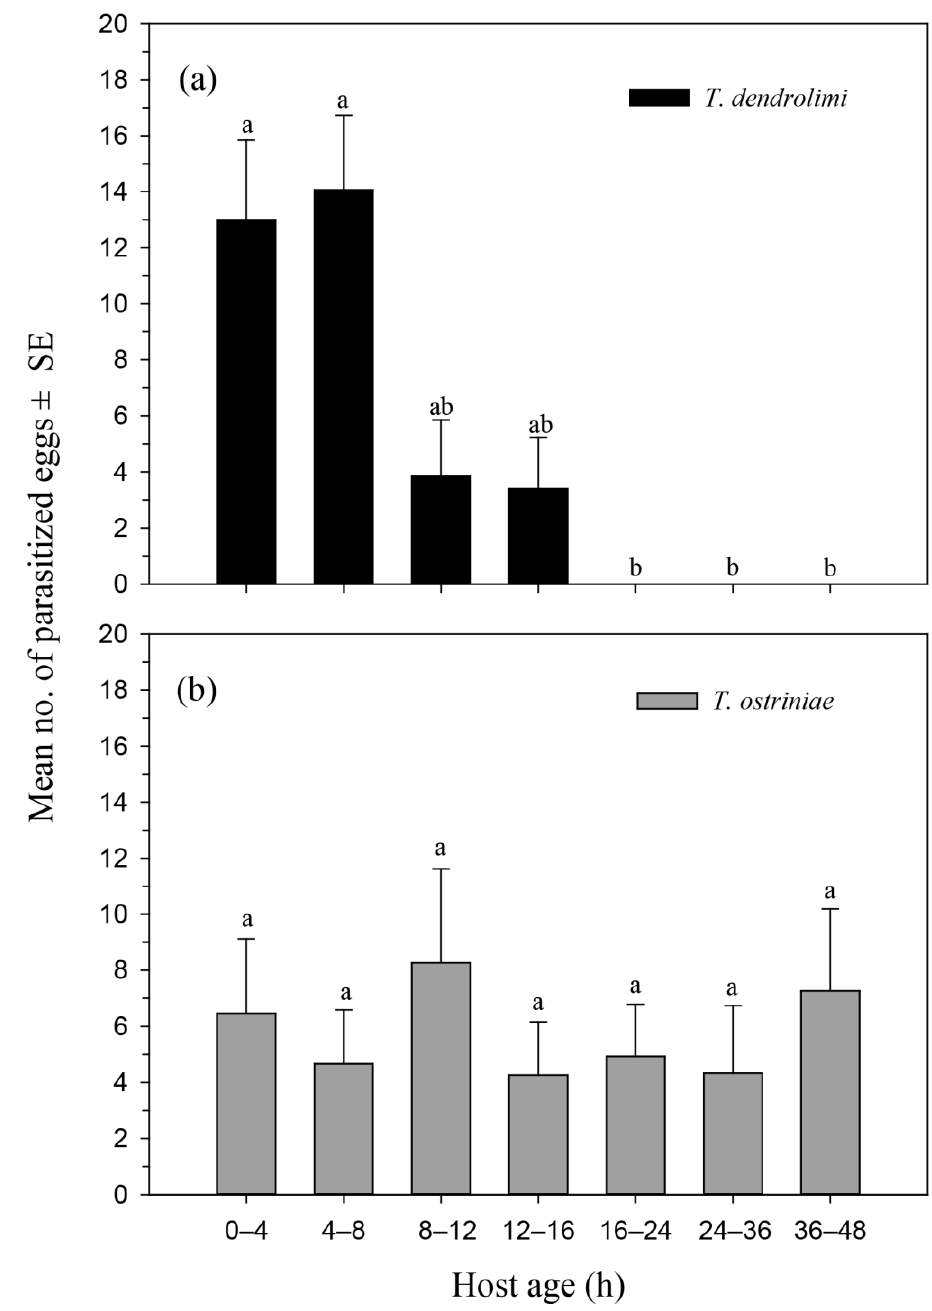
Figure 2. Suitability of the Asian corn borer (ACB) eggs as host stages for the parasitization by Trichogramma dendrolimi ( a ) and Trichogramma ostriniae ( b ) under choice conditions. Mean No. of parasitized eggs ± SE are shown. Different lower-case letters on the top of bars indicate significant differences in parasitization of T. dendrolimi and T. ostriniae on various ages ACB eggs (Friedman test, p < 0.05).